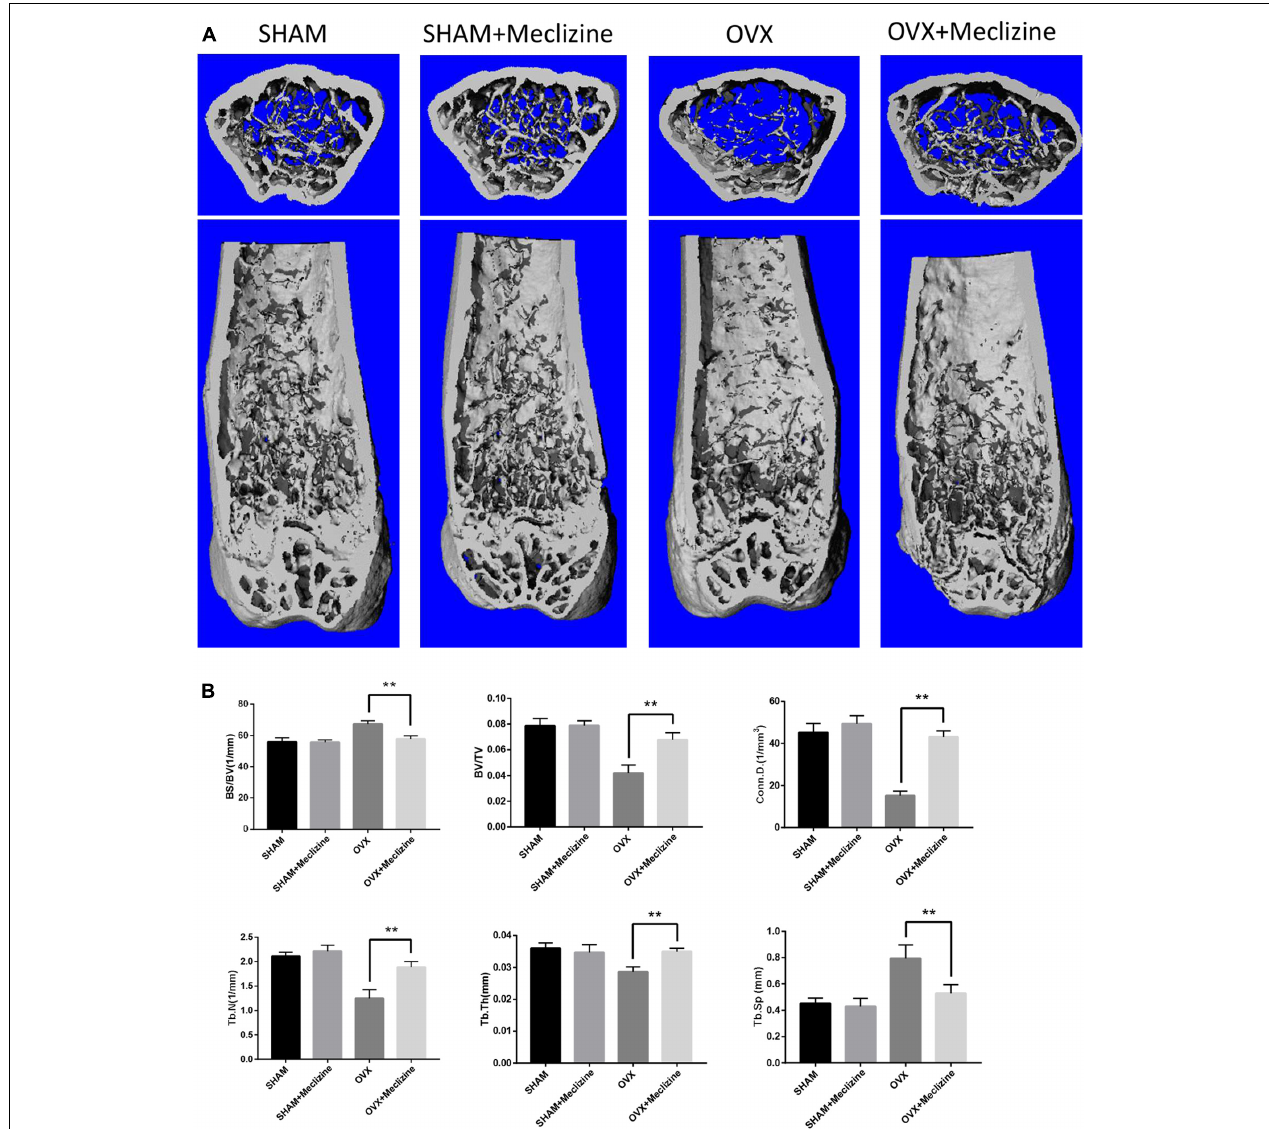
FIGURE 4 | Meclizine prevents bone loss in OVX mice. (A) Micro-CT images of the distal femoral metaphyseal region from the SHAM, SHAM + meclizine, OVX, and OVX + meclizine groups. (B) Histograms represent the trabecular structural parameters of the distal femur: bone surface/trabecular bone volume (BS/BV), trabecular bone volume/tissue volume (BV/TV), connectivity density (Conn.D), trabecular number (Tb.N), trabecular thickness (Tb.Th) and trabecular separation (Tb.Sp). Data are presented as means ± SD. n = 10. ∗∗ P <